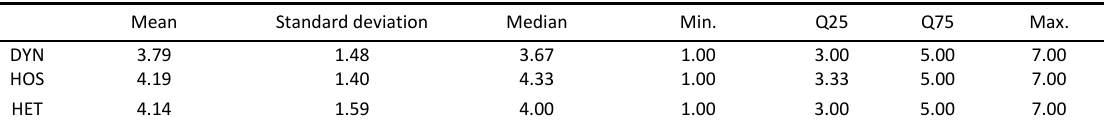
Table 5: Descriptive statistics for ENV variable